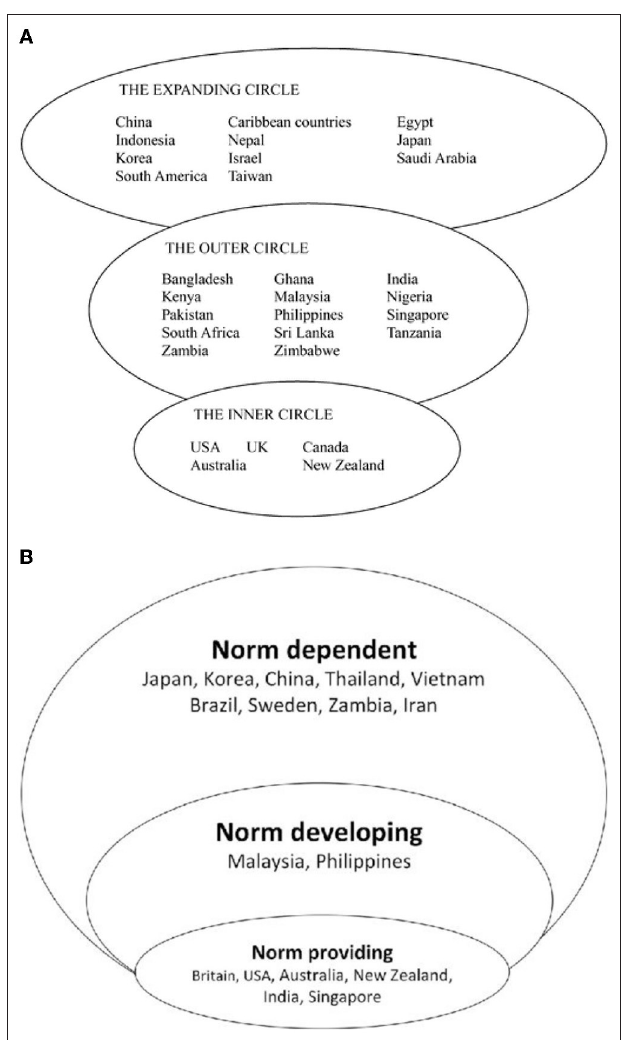
FIGURE 4 | (A) Kachru’s “Three Circle of English” model (adapted from Kachru, 1982). (B) Kachru’s “Three Circle of English” model (adapted from Haswell, 2013) 4